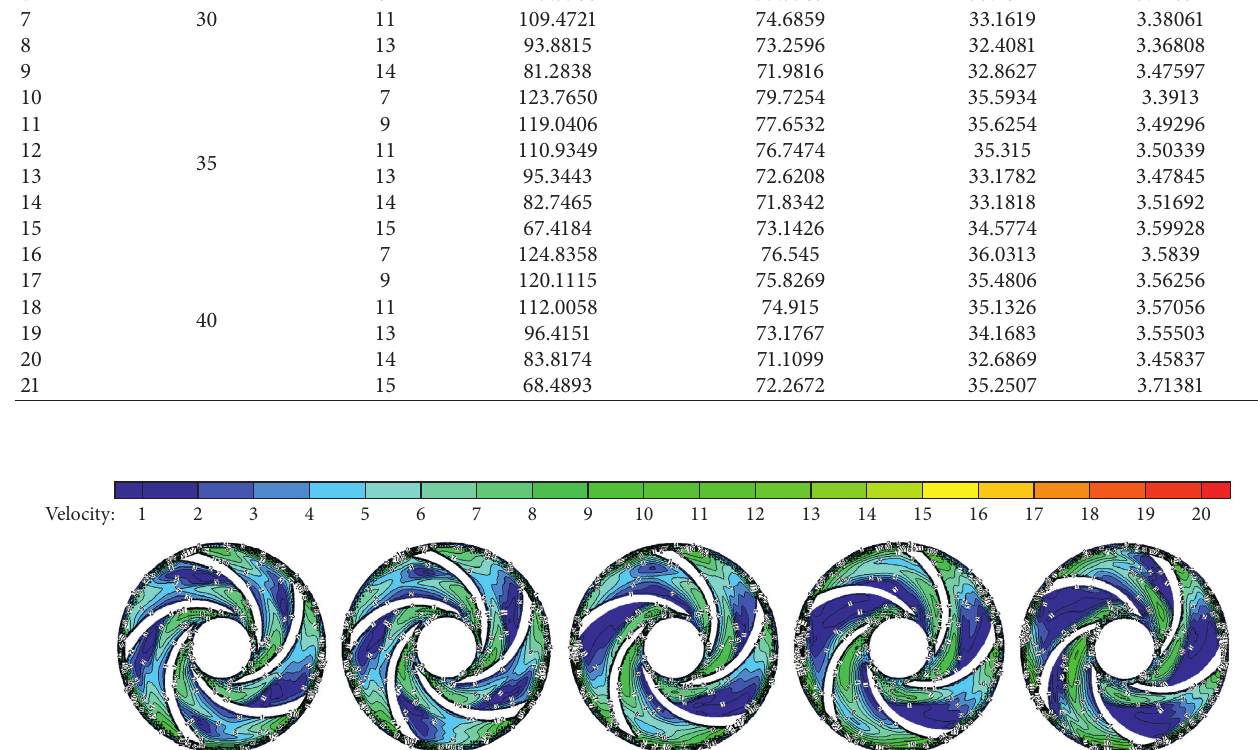
Figure 25: Velocity cloud chart of the impeller with different inlet angles.